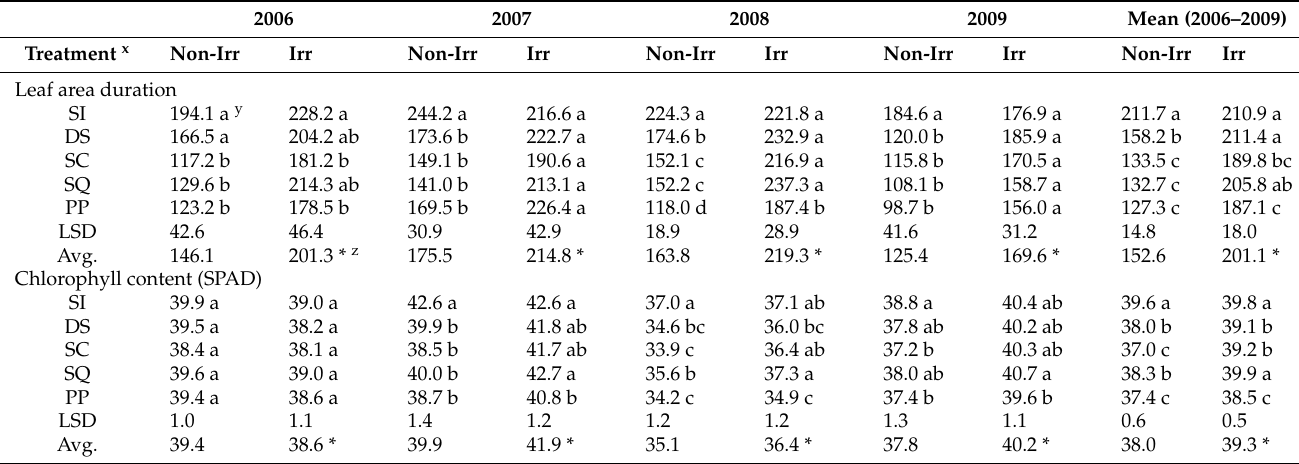
x SI = soil improving, SC = soil conserving, DS = disease suppressive, SQ = status quo, PP = continuous potato systems. y Values within columns for each parameter followed by the same letter are not significantly different from each other based on ANOVA and Fisher’s protected LSD test ( p < 0.05). z Mean values for irrigated treatments followed by an asterisk are significantly greater than their corresponding non-irrigated mean value within each year based on ANOVA and Fisher’s protected LSD